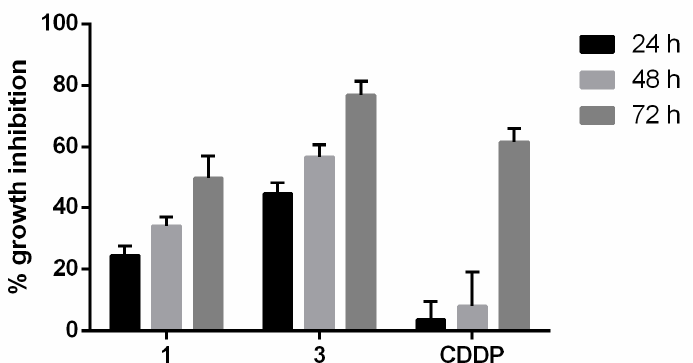
Figure 6. Growth inhibition percentage in T24 spheroids by compounds 1 , 3 or cisplatin (CDDP) at IC 50 during 24, 48 and 72 h. The data are the means ± standard deviation obtained from three deter-